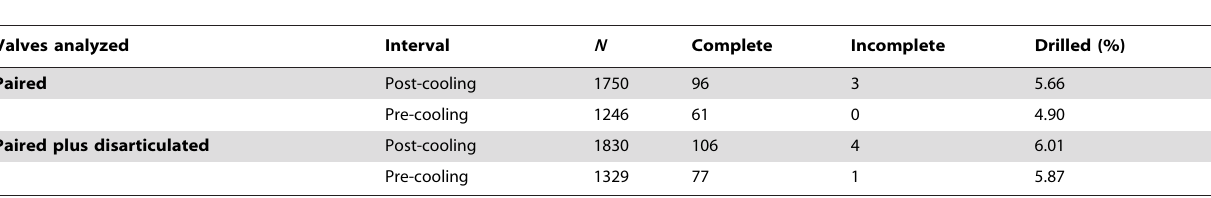
Table 3. Frequencies of naticid drillholes in Eurhomalea spp. bivalves from the La Meseta Formation.